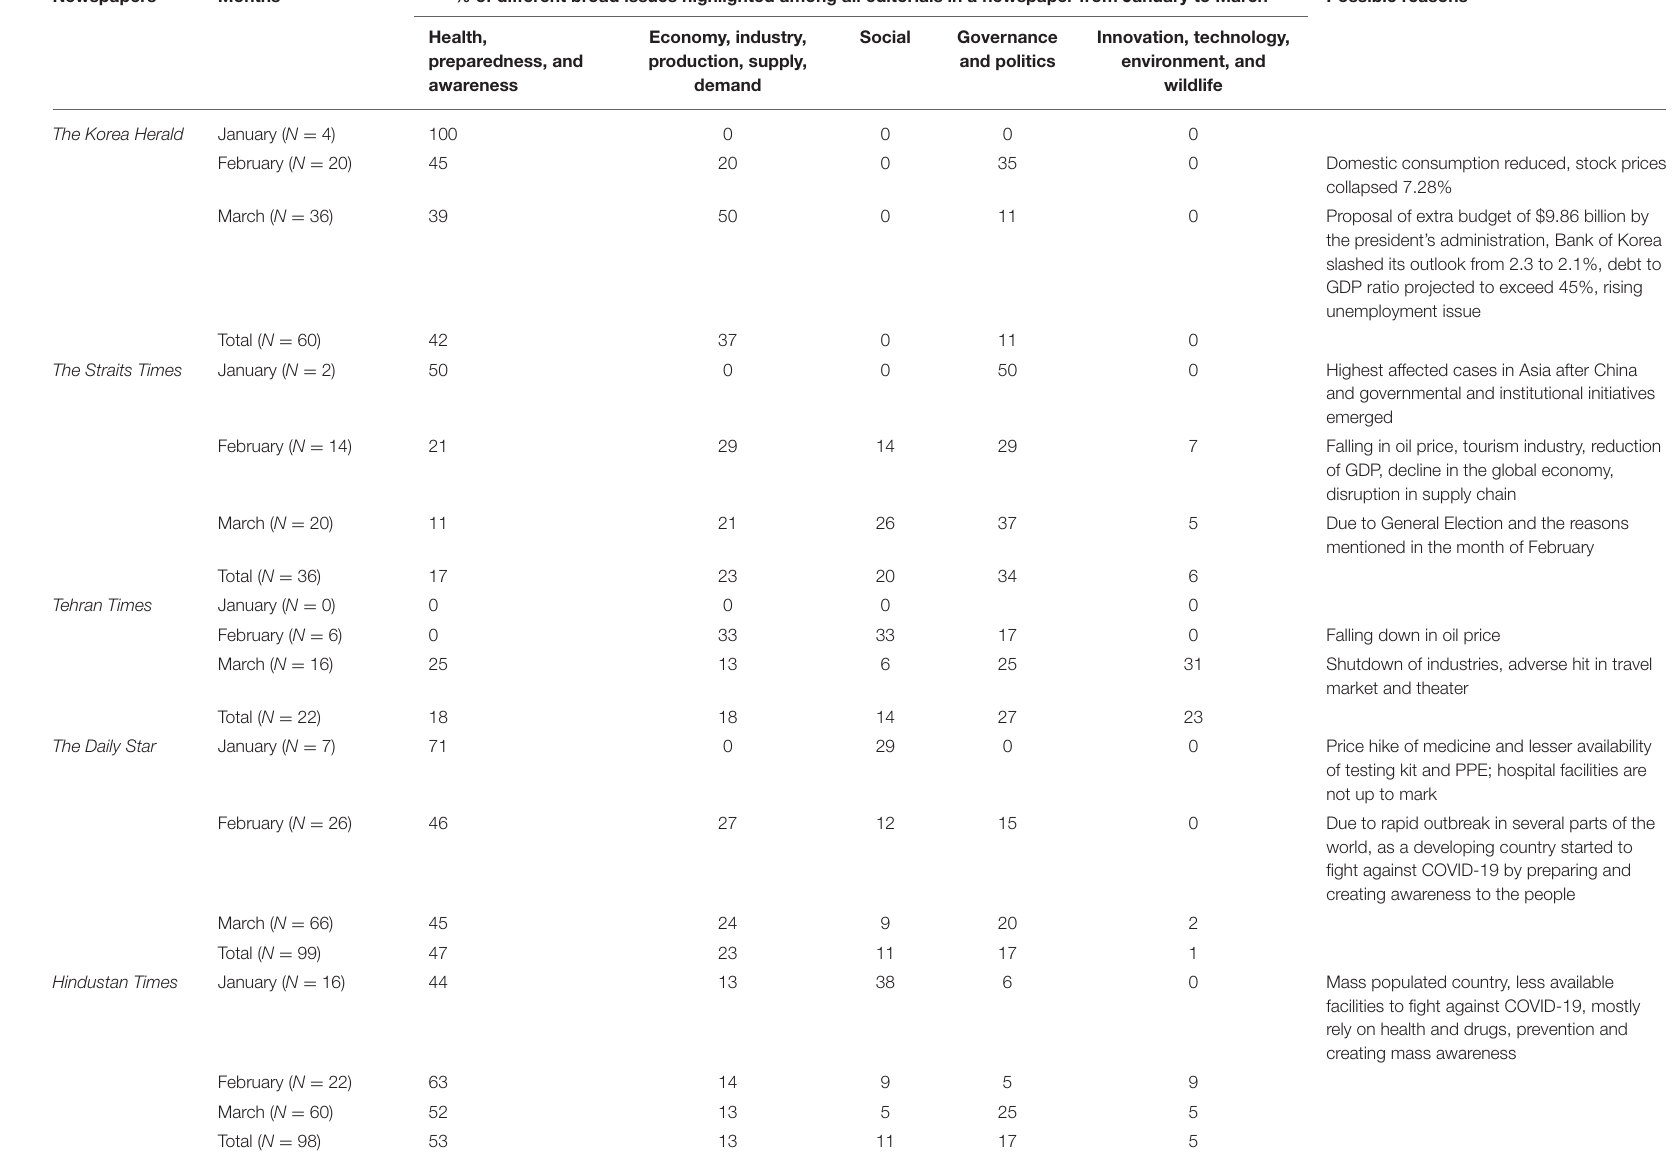
TABLE 10 | Comparison of different areas of focus of e-newspapers in five Asian countries. Newspapers Months % of different broad issues highlighted among all editorials in a newspaper from January to March Possible reasons